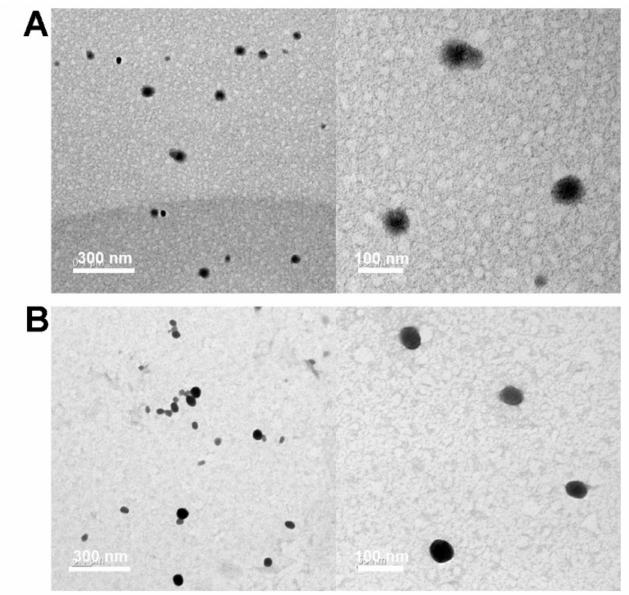
Figure 4. Transmission electron microscopy (TEM) images of ( A ) SP2K7 polyplexes and ( B ) SP2K10